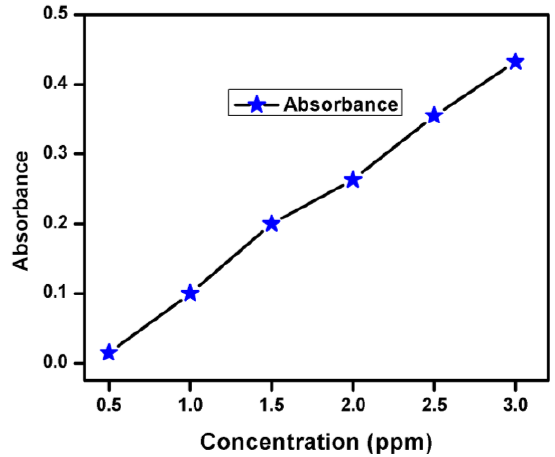
Figure 6. Determination of phenol using Antipyratic method.